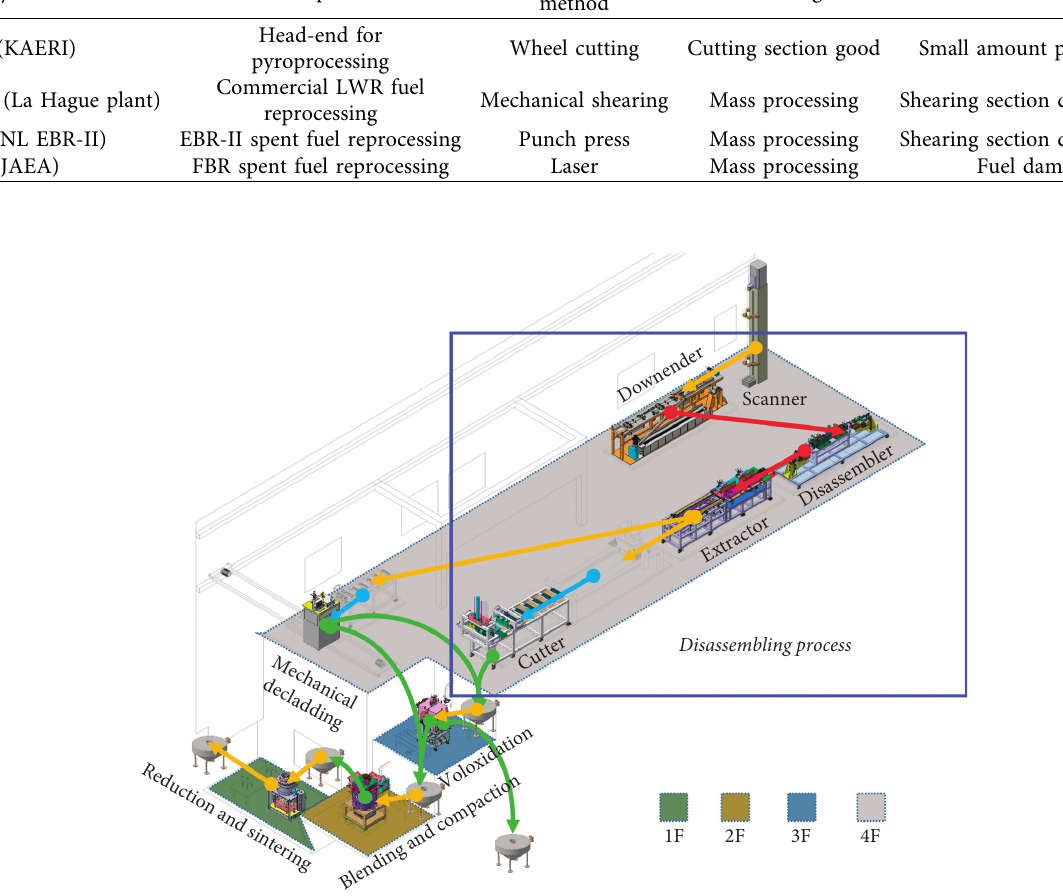
Figure 2: Disassembly during dry head-end process.